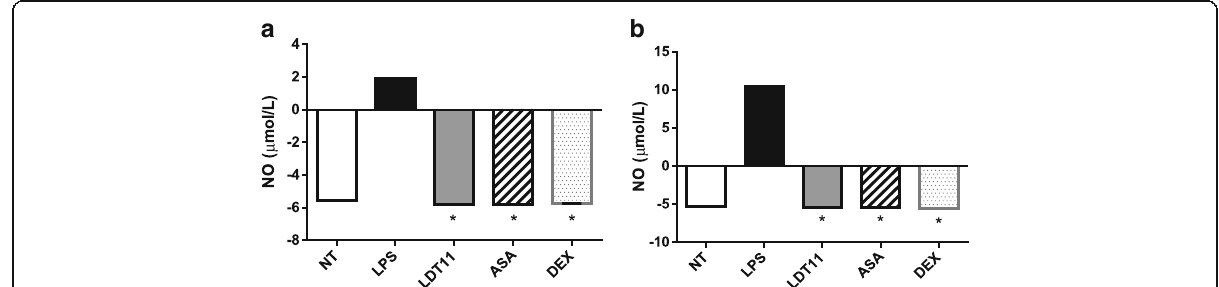
Fig. 11 Evaluation of the potential immunoprotective effect of the CNSL derivatives by measuring the levels of nitric oxide production in the supernatant at 6 h ( a ) and 24 h ( b ) post-stimulus. NT- untreated cells; LPS - LPS-stimulated cells; LDT11 - cells treated with LDT11 and then with LPS; AAS - cells treated with commercial acetylsalicylic acid and then with LPS; DEX - cells treated with the commercial anti-inflammatory Dexamethasone and then with LPS. All data are from at least three independente experiments, * p < 0.05, statistically different compared with cells LPS-stimulated